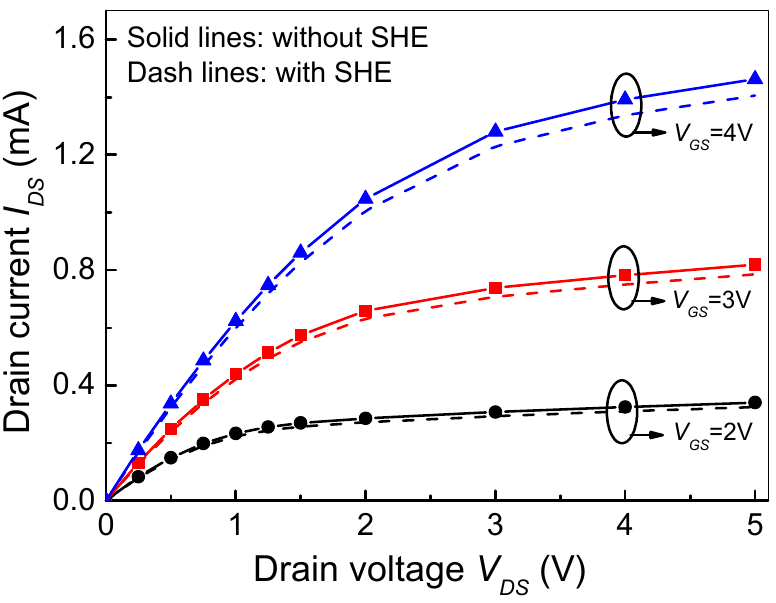
Figure 10. Output characteristic curve of vertical MOSFETs with, and without, consideration of the SHE.